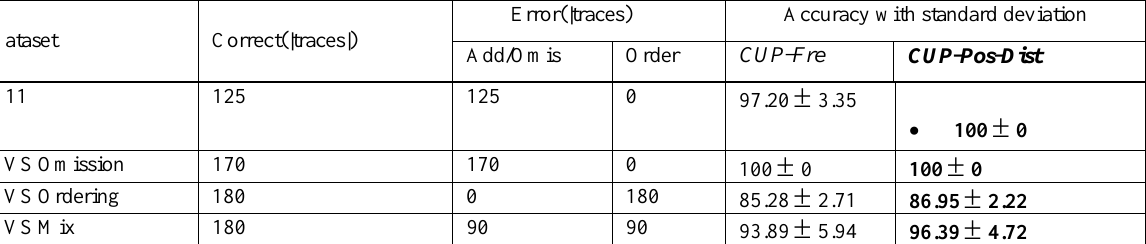
Table 6. Experiments 1: comparison results on synthetic datasets